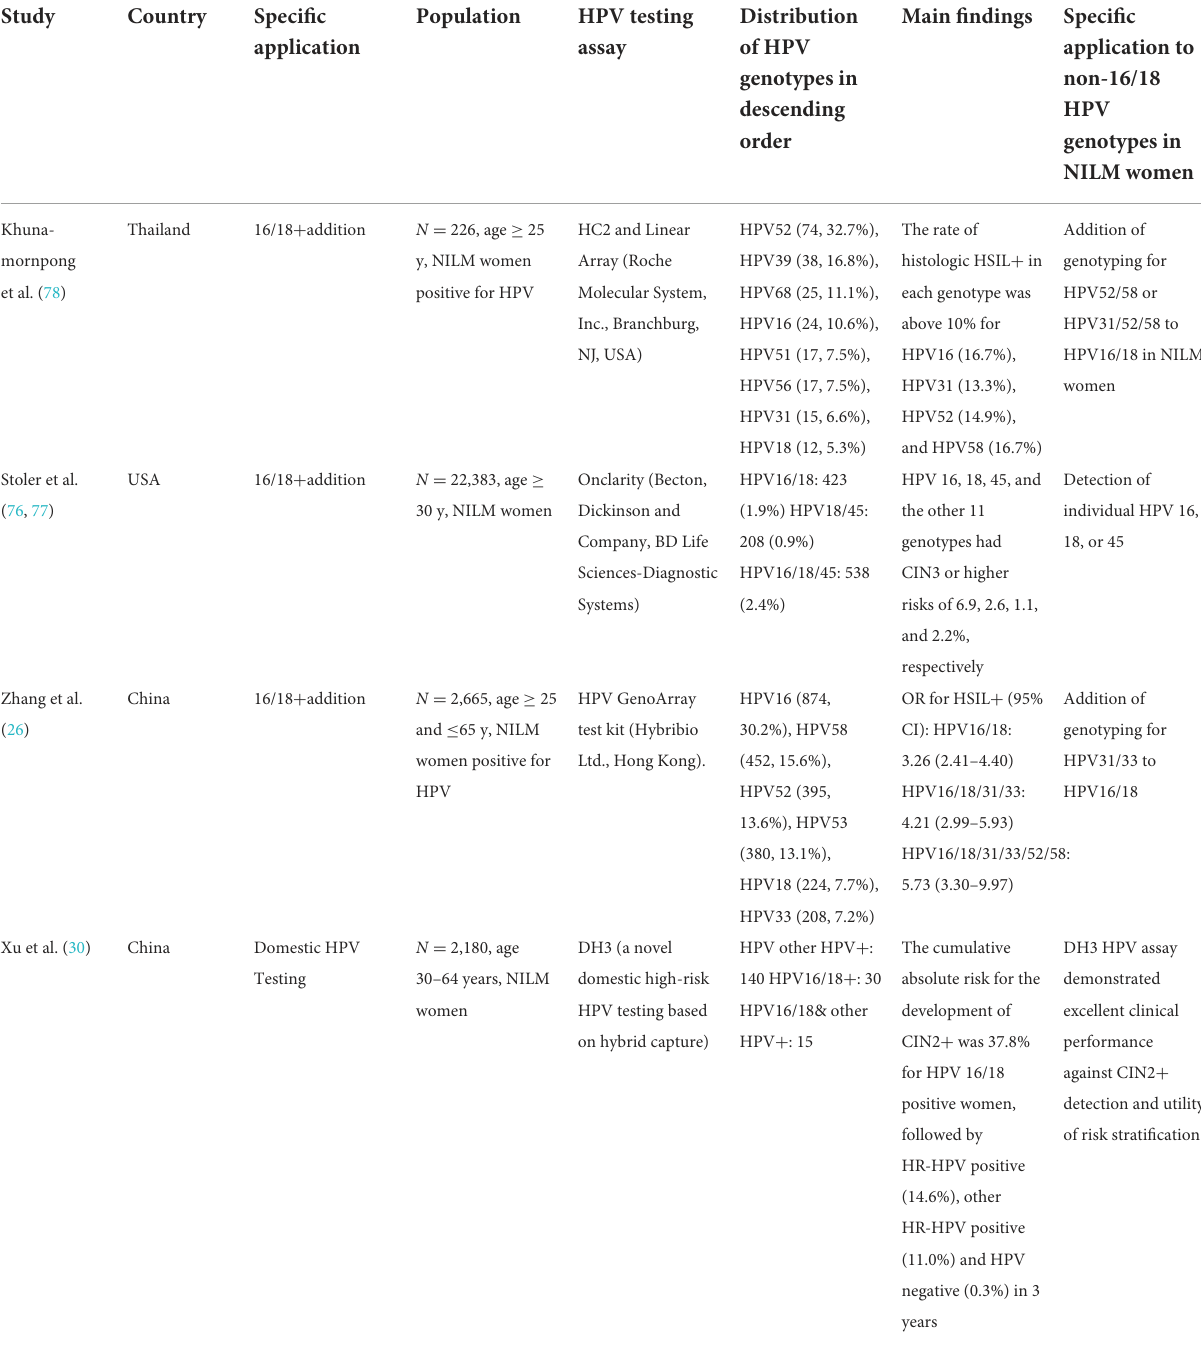
TABLE 5 Specific application to non-16/18 HPV genotypes in different geographical